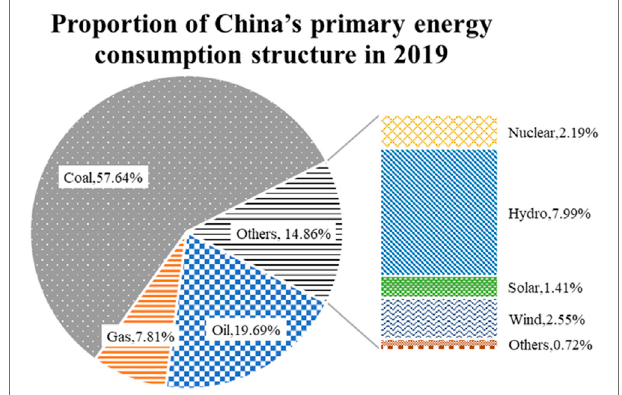
FIGURE1| ProportionofChina ’ sprimaryenergyconsumptionstructure in